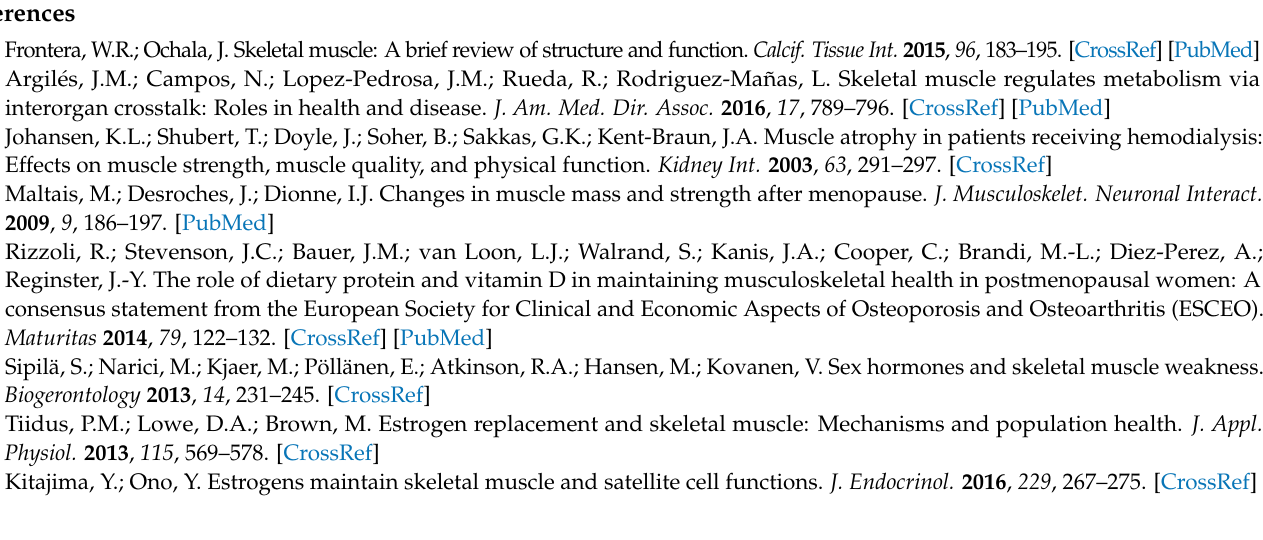
Table S2: Antibodies for immunoblot & immunofluorescence; Table S3: Normality distribution (Rotarod test and Inverted screen test); Table S4: Dunnett’s test (Rotarod test and Inverted screen test); Figure S1: Effects of PNF on the viability of primary differentiated myoblast cells treated with the indicated concentrations for 72 h. ( n = 3). * p < 0.05, ** p < 0.01, and *** p < 0.001; Figure S2: PNF selectively recovers the TNF α -induced reduction of NRF1 and TFAM transcripts, but not PGC1 α in C2C12 cells. TNF α (10 ng/mL), PNF was treated in cells for 24 hours. (A) PGC1a, (B) NRF1, (C) TFAM. * p < 0.05, ** p < 0.01, and *** p < 0.001. N.S., not